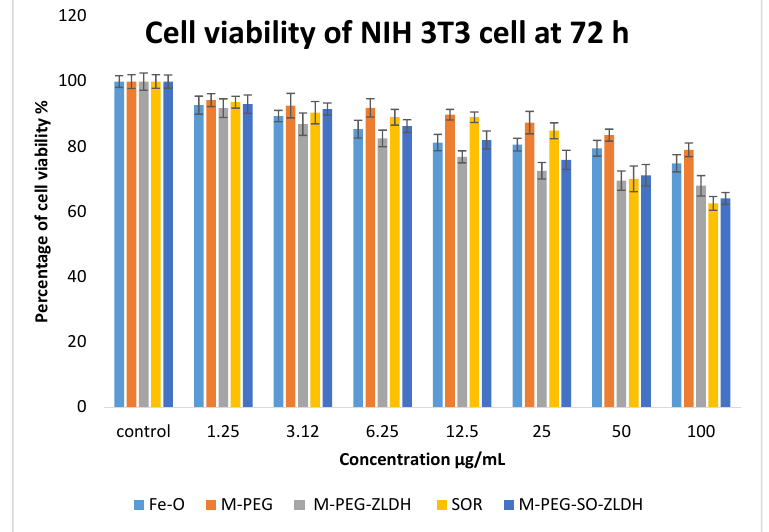
Figure 13. Cytotoxicity assay of Fe–O, M-PEG, M-PEG–ZLDH (the nanocarriers), pristine sorafenib, and M-PEG–SO–ZLDH against normal 3T3 cells at 72 h. Results were calculated as mean ± standard deviation for n = 3 independent experiments.